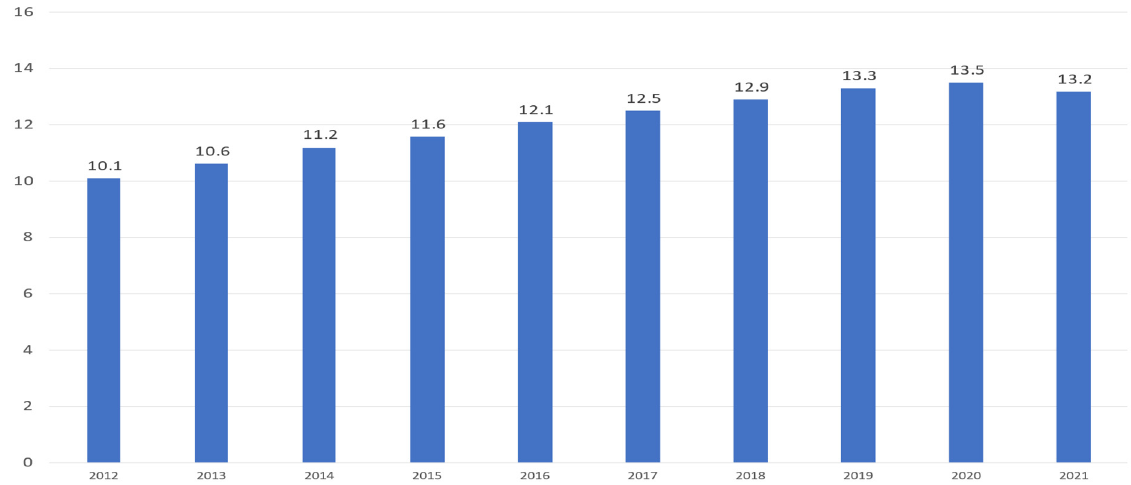
Figure 13. Geographic Mobility Rates (% of population). Source: Current Population Survey.